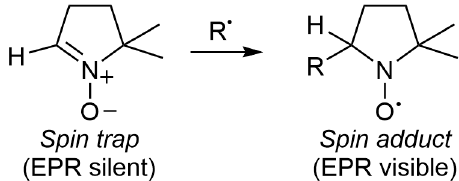
Figure 1. Principle of spin trapping with DMPO. The short-lived radical R • adds to the cyclic nitrone to form a persistent nitroxide radical that can be detected by EPR. to form a persistent nitroxide radical that can be detected by